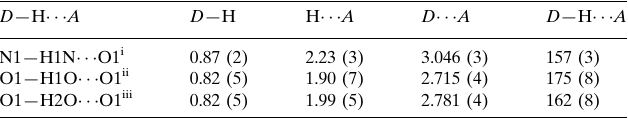
Hydrogen-bond geometry (A˚ , (cid:2)